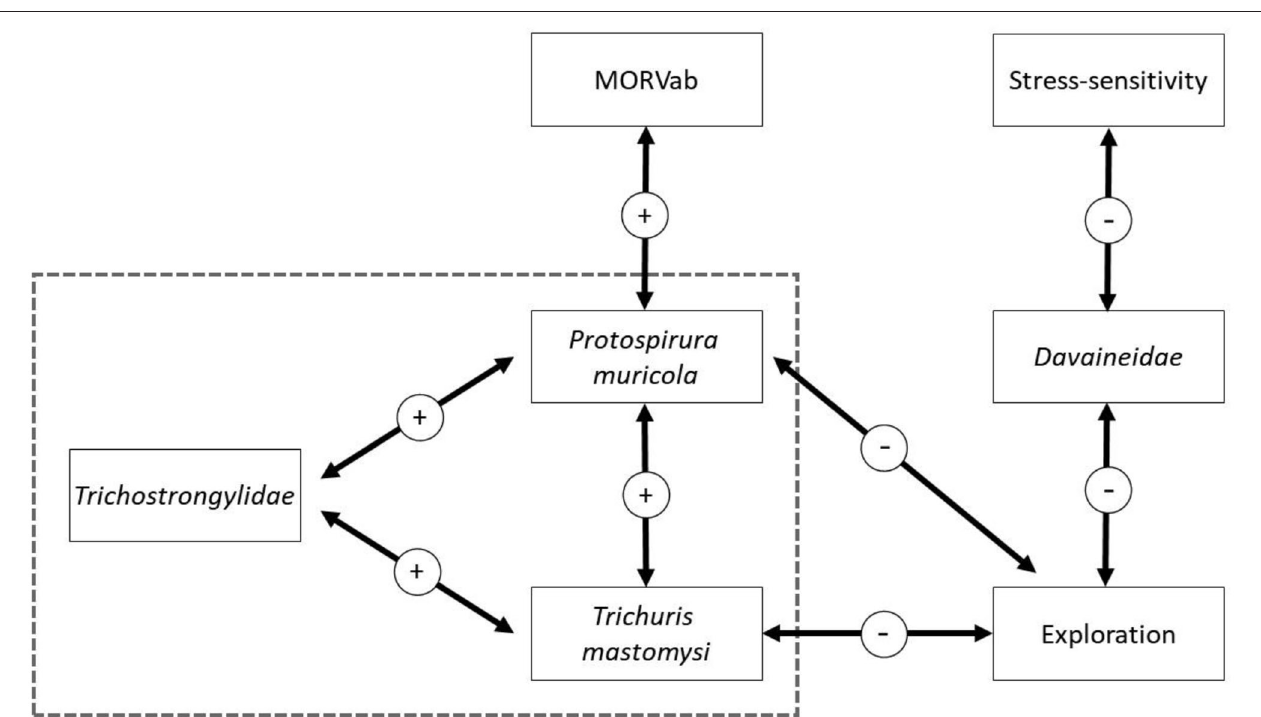
FIGURE 3 | Graphical summary of the results from the presence-absence HMSC model. Arrows indicate strong correlation, with 95% posterior probability support, between the two variables. Arrows within the dashed square are derived from the co-occurrence results (the omega parameters) while the arrows outside are derived from the beta estimates. The sign of the estimate is given in the circle.